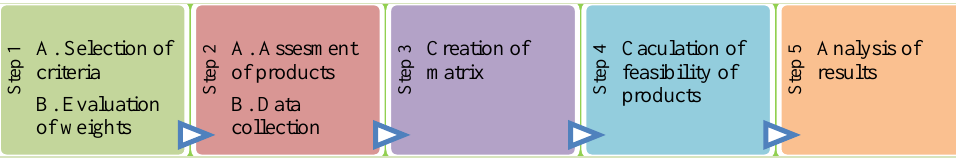
Fig. 3. Step-by-step